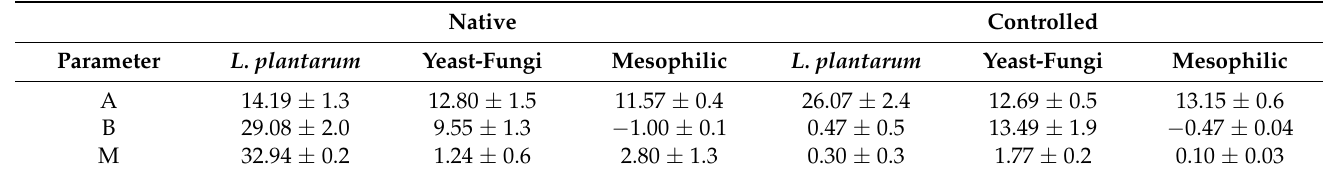
Table 2. Kinetic of growth of native and controlled fermentation ( L. plantarum ) of the C. ficifolia juice at 30 °C (Mean ± S.D., n = 3). Specific growth rate µ (h − 1 ) was determined using the linear equation of the exponential growth.